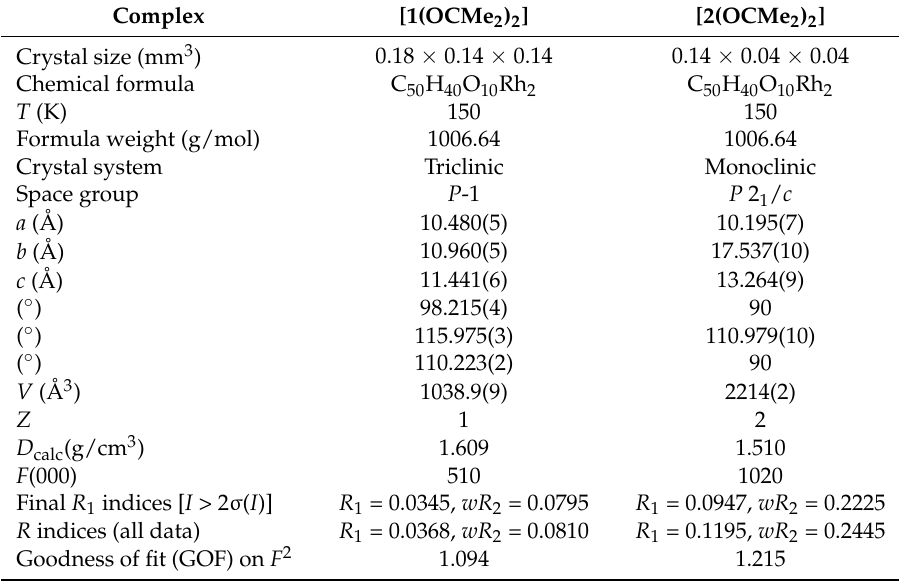
Table 1. Crystallographic data for complexes [1(O 2 CMe 2 ) 2 ] and [2(O 2 CMe 2 ) 2 ] .